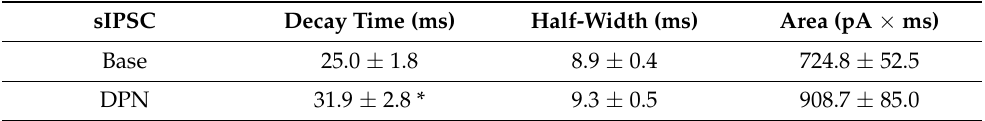
Table 2. Kinetics of spontan GABAergic currents in Base and after application of DPN in males.